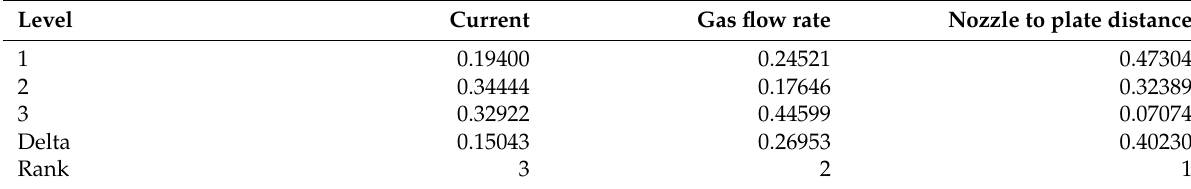
Table 6: Response table for mean overall desirability